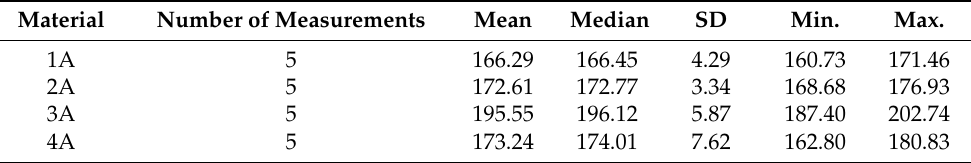
Table 3. Basic descriptive statistics of the scratch hardness results based on the measurements made using the optical microscope ( Hs mic ) in individual material groups.